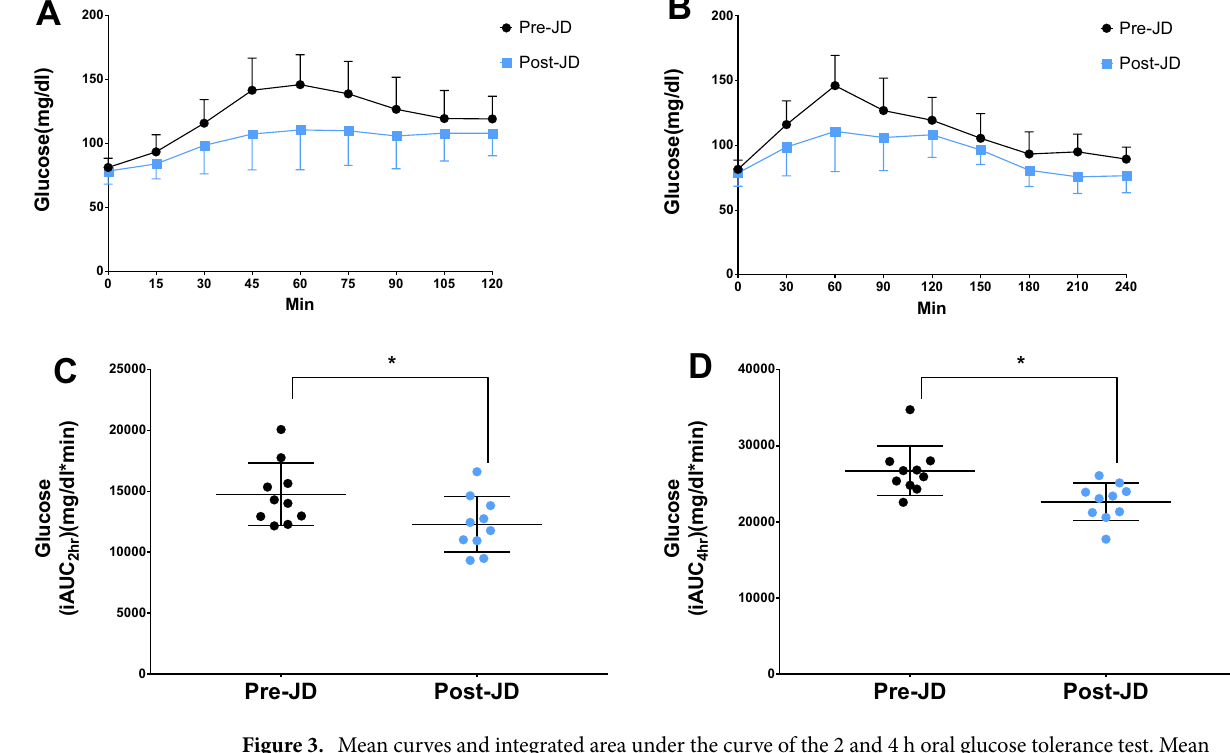
Figure 3. Mean curves and integrated area under the curve of the 2 and 4 h oral glucose tolerance test. Mean and standard deviation for each time point of the 2 h ( A ) and 4 h ( B ) Oral Glucose Tolerance Test (OGTT), before (Pre-JD) and after (Post-JD) 7 days of passive simulated jogging (JD). Mean and standard deviation for the Integrated Area Under Curve (iAUC) of the 2 h ( C ) and 4 h ( D ) OGTT for each subject, before (Pre-JD) and